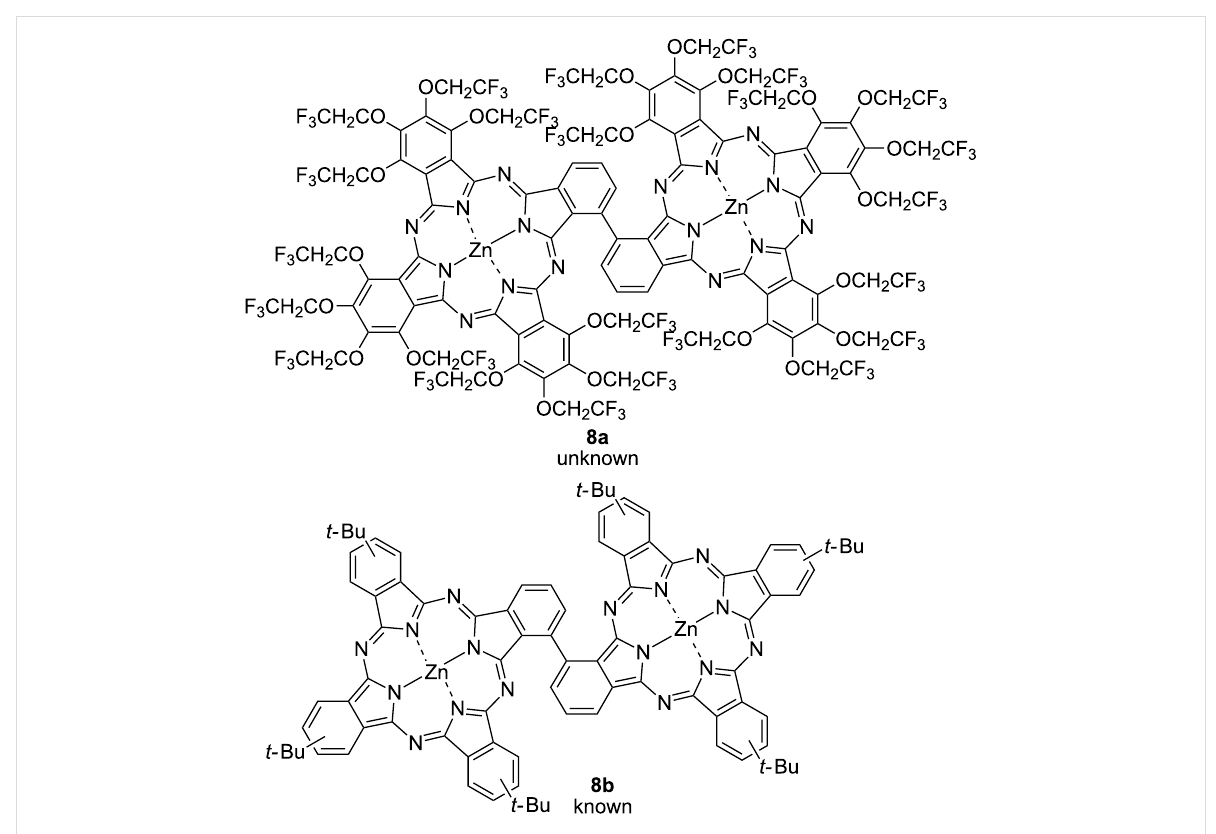
Figure 1: Structure of trifluoroethoxy-substituted phthalocyanine dimers linked at the α -position.